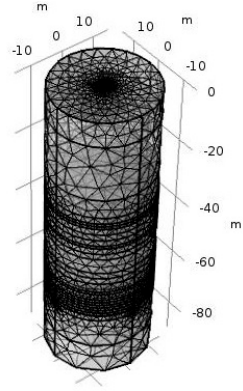
Figure 15. Oklahoma formation model.